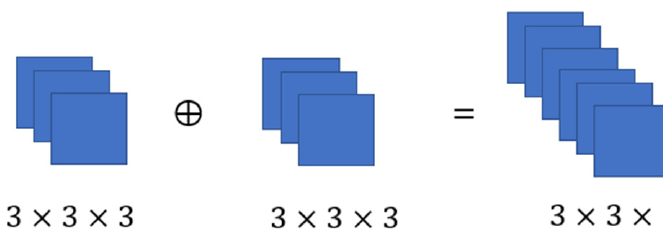
Figure 7. Schematic diagram of feature dimension superposition.